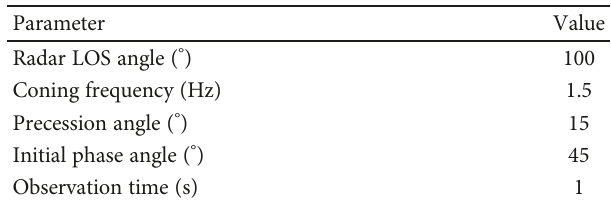
Table 1: Parameter